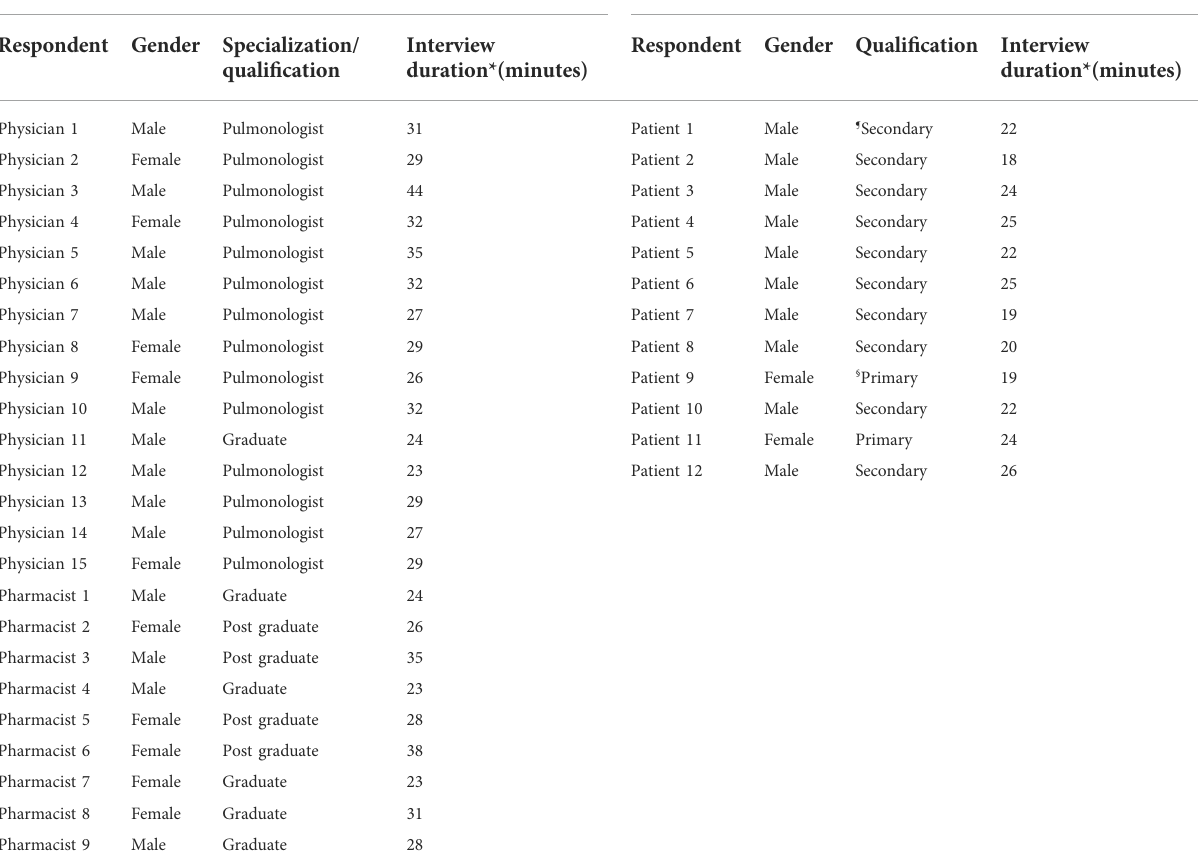
TABLE 2 Characteristics of the